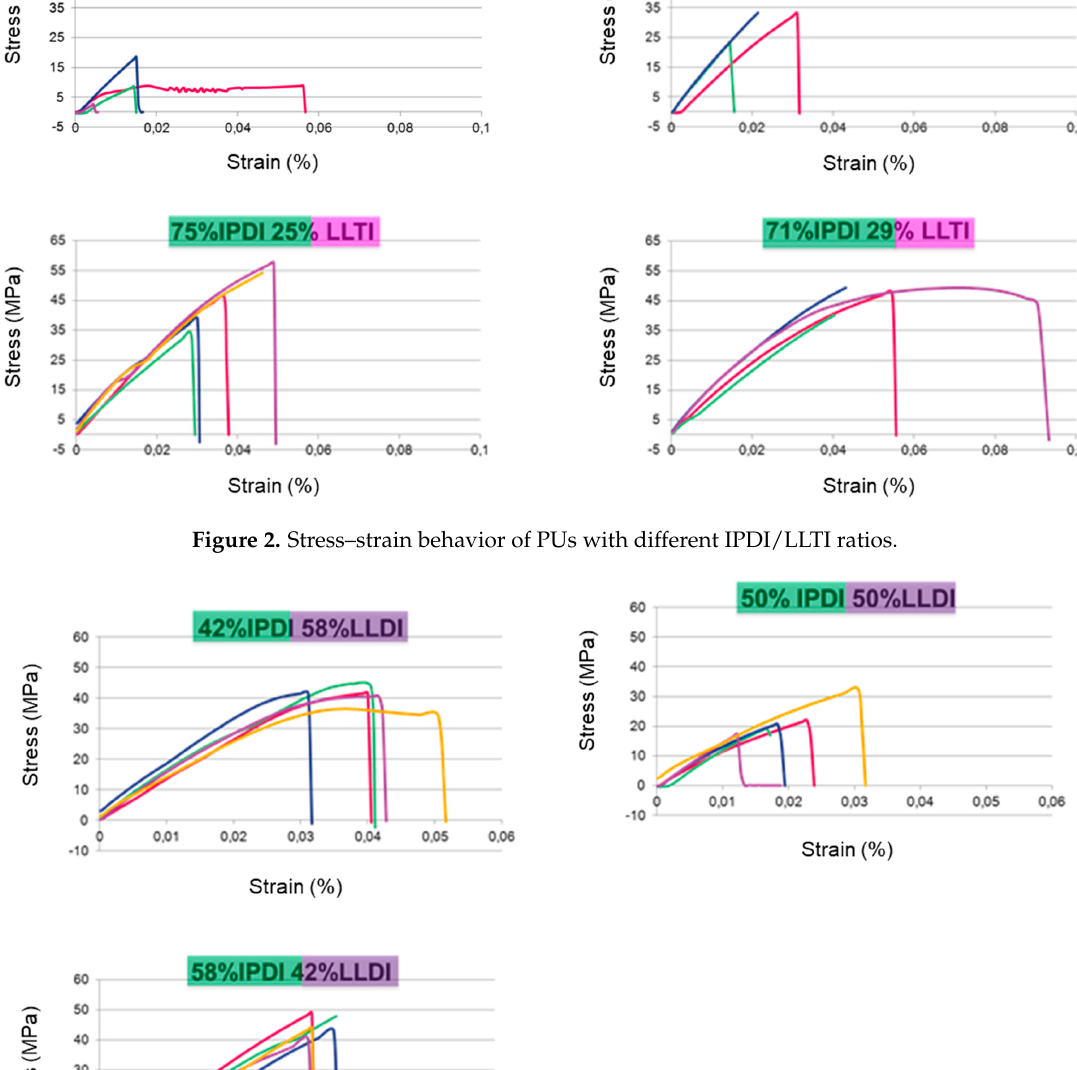
Figure 2. Stress–strain behavior of PUs with different IPDI/LLTI ratios.